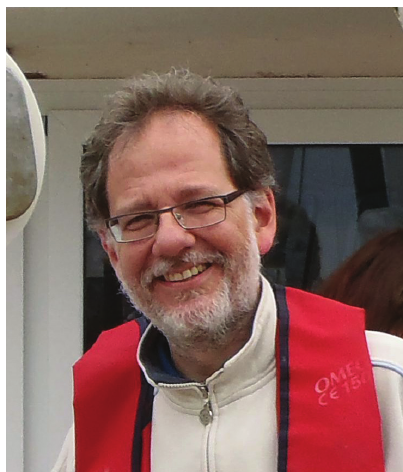
Figure 10. Dr. Julio Parapar. The photograph was taken by Dr. Juan Moreira.